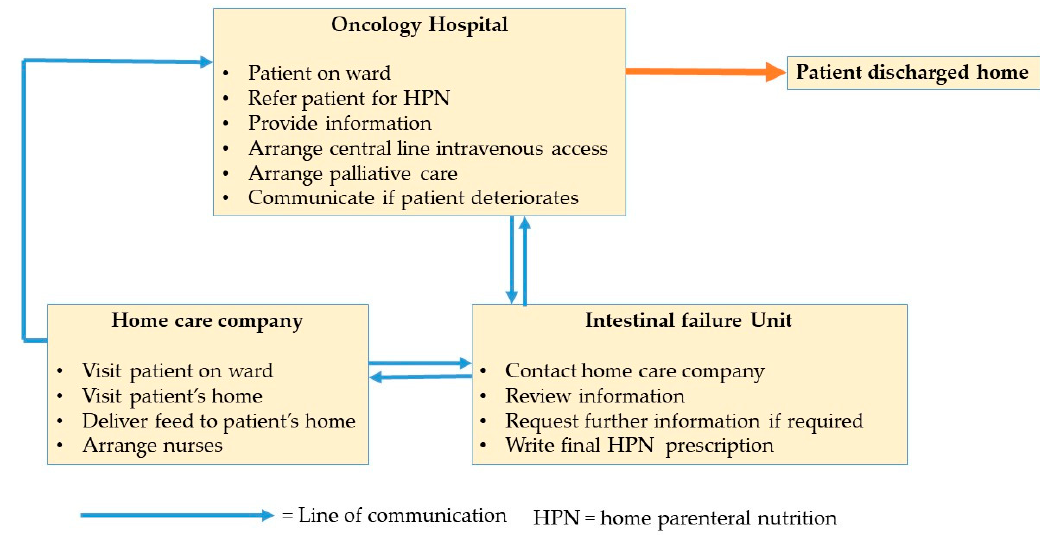
Figure 1. Pathway for patient discharge on home parenteral nutrition.